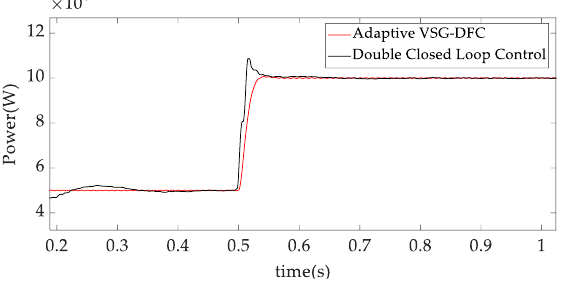
Figure 18. Output power of MMC-RPC under two control methods.